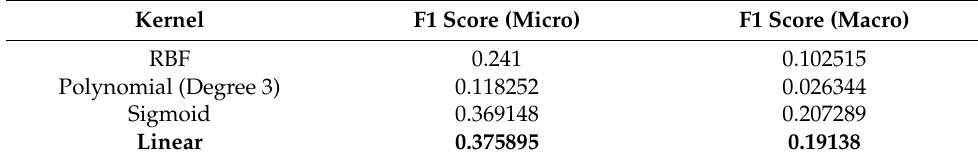
Table A5. SVM tuning: F1 score (micro and macro averaged) for different kernels. Although the F1 macro average score is higher for the linear kernel, micro averaging is less susceptible to fluctuations from class imbalance, therefore this was chosen as the deciding factor. Tests performed using the constant processing pipeline. Selected weighting method shown in bold.